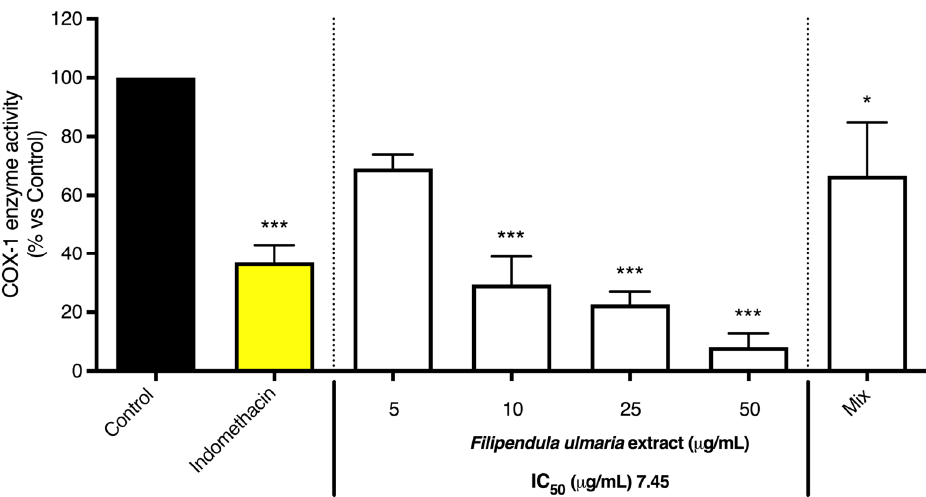
Figure 8. The effect of the F. ulmaria extract and the mix (20 µ M of gallic acid and salicylic acid, 6 µ M of quercetin and 4 µ M of syringic acid) on COX-1 enzyme inhibition. Indomethacin (1.25 µ M), in yellow, served as positive control. The graph depicts compiled data of three independent experiments (mean ± SD). p -values are expressed as * p < 0.05 and *** p < 0.0001 compared to control.